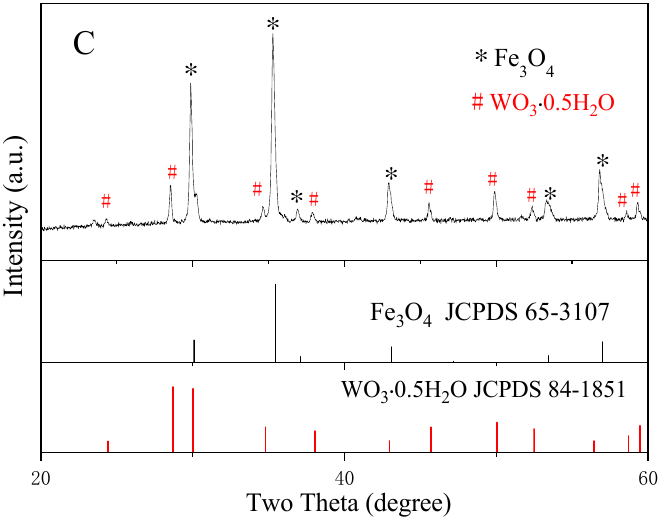
Figure 1. ( a ) Indexed powder XRD pattern of the Fe 3 O 4 products and ICDD files of Fe 3 O 4 ; ( b ) indexed powder XRD pattern of γ -Fe 2 O 3 /WO 3 ·0.5H 2 O samples and ICDD files of γ -Fe 2 O 3 and WO 3 ·0.5H 2 O; ( c ) indexed powder XRD pattern of the samples prepared in the absence of PAF-50. XPS spectra were performed to determine the valence state of the elements. Figure 2b shows the spectrum of Fe 2p; the locations at 711.1 and 724.8 eV correspond to Fe 2p 3/2 and Fe 2p 1/2 [54,55]. The satellite peak of Fe 2p 3/2 for Fe 2 O 3 is located approximately 8 eV higher than the main Fe 2p 3/2 peak. In addition, there appears to be another satellite peak at 733.5 eV, which may be a satellite peak for Fe 2p 1/2 [56]. The corresponding satellite peak around 719.1 eV confirms the γ -Fe 2 O 3 phase, which is consistent with the results of XRD [57]. During this hydrothermal reaction, Fe 3 O 4 has a phase transformation to Fe 2 O 3 . In Figure 2c, the W 4f binding energies of two peaks located at 35.7 eV and 37.8 eV correspond to +6 valence of W. The whole spectra (Figure 2a) show that content of W is much higher than that of Fe. We can infer that WO 3 covers the surface of Fe x O y during the synthesis of hybrid nanostructure. Additionally, XPS is a surface-sensitive analytical technique [58]. Thus, the intensity of Fe 2p peak is weak.